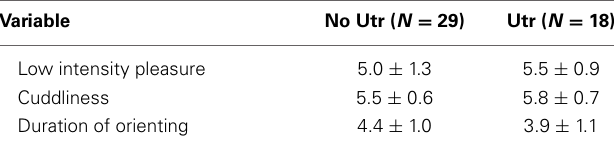
Table 1 | Demographic characteristics of mothers with or without